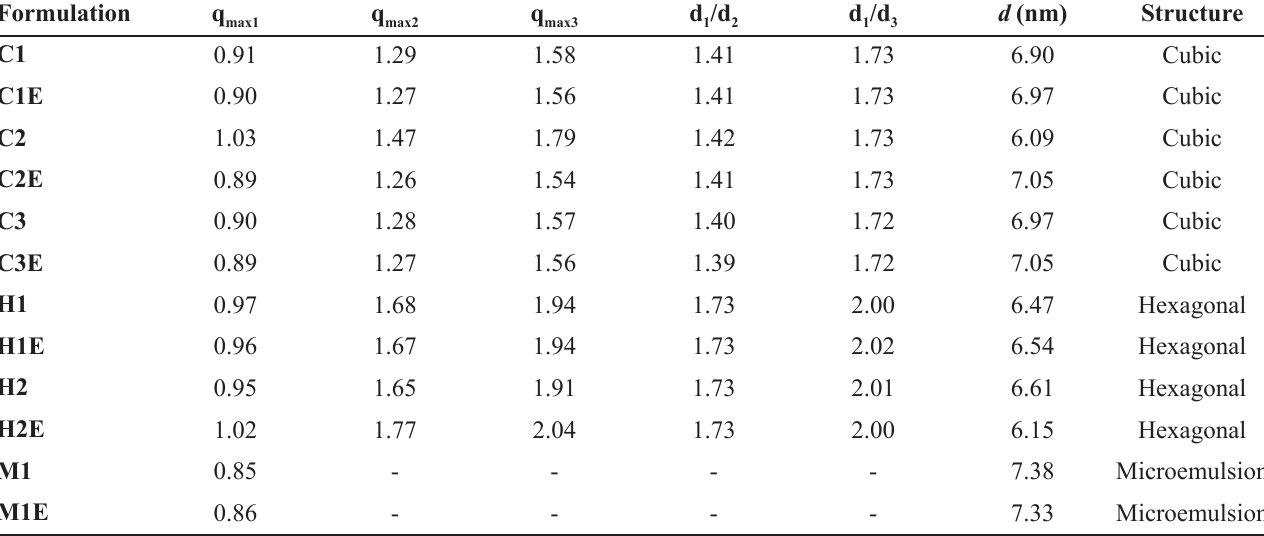
TABLE II - Ratio of the interplanar distances and lattice parameter d (nm) for the formulations obtained by SAXS Formulation